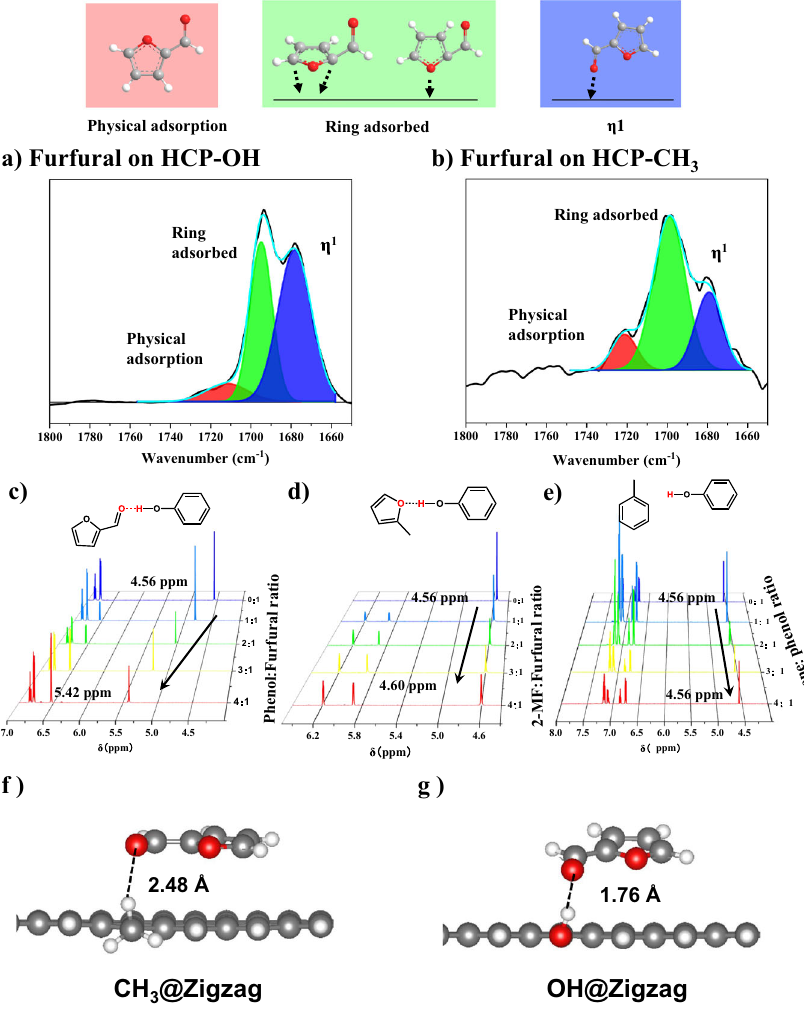
Fig. 4 | Hydrogen bond interaction of the substrate with different scaffolds. Drifts IR of furfural on ( a ) HCP-OH and ( b ) HCP-CH 3 . Concentration-dependent 1 H-NMR results of ( c ) furfural with phenol, ( d ) 2-MF with phenol, and ( e ) toluene